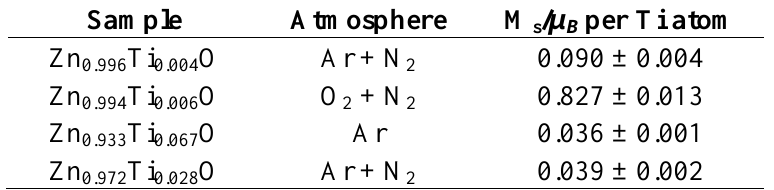
Table 1. Composition, saturation magnetic moments M on Si(100) substrate and the ambient atmosphere under which the films were